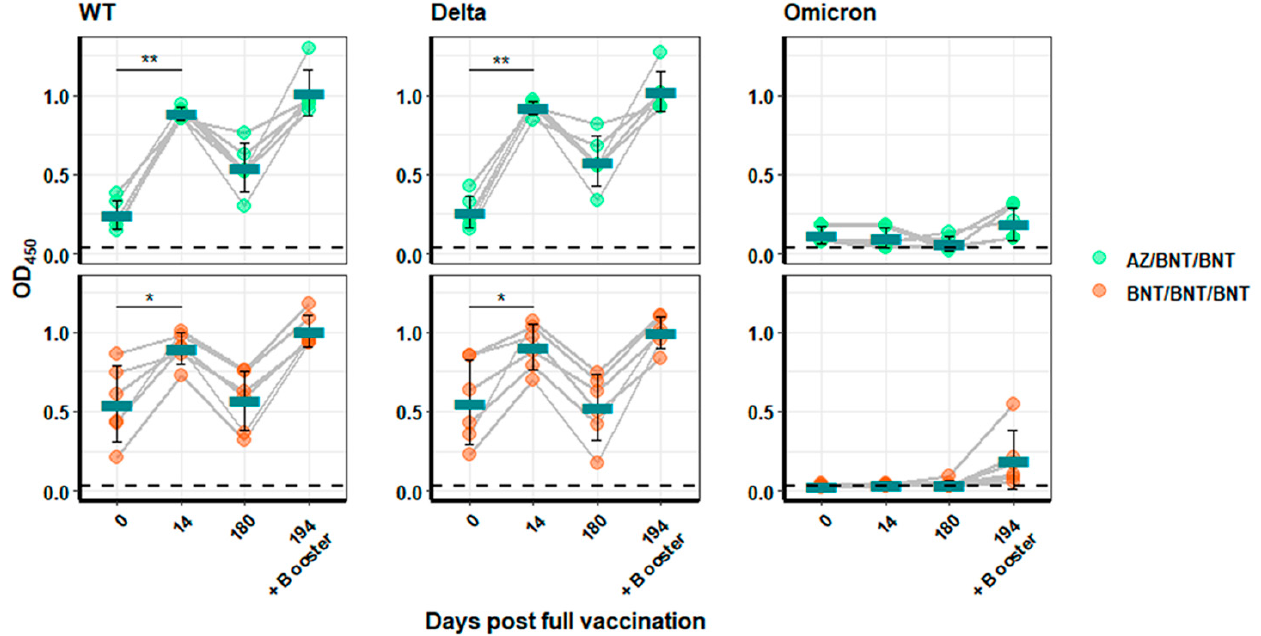
Figure 4. Analysis of RBD binding in sera of heterologous or BNT-vaccinated individuals . IgG binding to the WT-, Delta-, or Omicron-RBD in sera from individuals who received either AZ/BNT/BNT (green) or BNT/BNT/BNT (orange) was analysed by ELISA. Blood samples were each collected at Days 0, 14, and 180 post full immunization and, furthermore, 14 days after a third booster dose. Binding is depicted as OD 450 values. Turquoise bars indicate the arithmetic mean for each group. Significance is indicated with two stars (**) for a p -value between 0.001 and 0.01, and one star (*) denotes a p -value between 0.01 and 0.05.